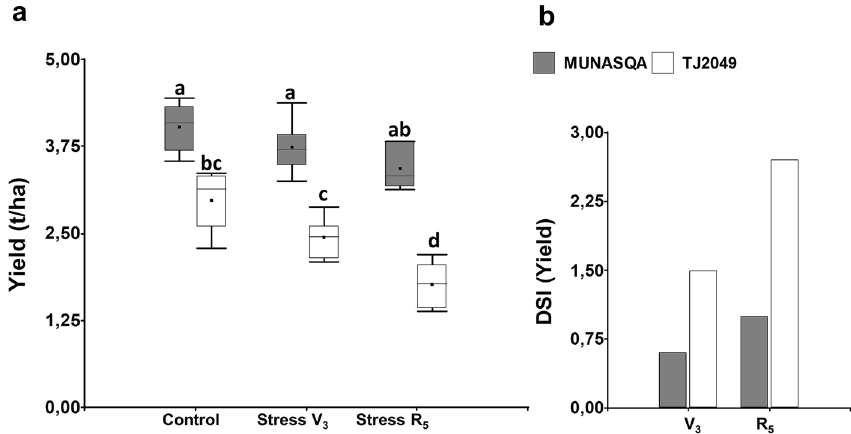
Figure 2. Effects of mild water deficit in MUNASQA and TJ2049 yield and yield-DSI. Yield in well-irrigated (Ψs = − 0.05 MPa) and drought-stressed (Ψs = − 0.65 MPa) V3 and R5 ( a ). Yield-DSI for each genotype phenotyped in V3 and R5 ( b ). Different letters indicate significant differences at P < 0.05 (two-way ANOVA). Error bars represent SE from independent experiments, n = 300 per trial.